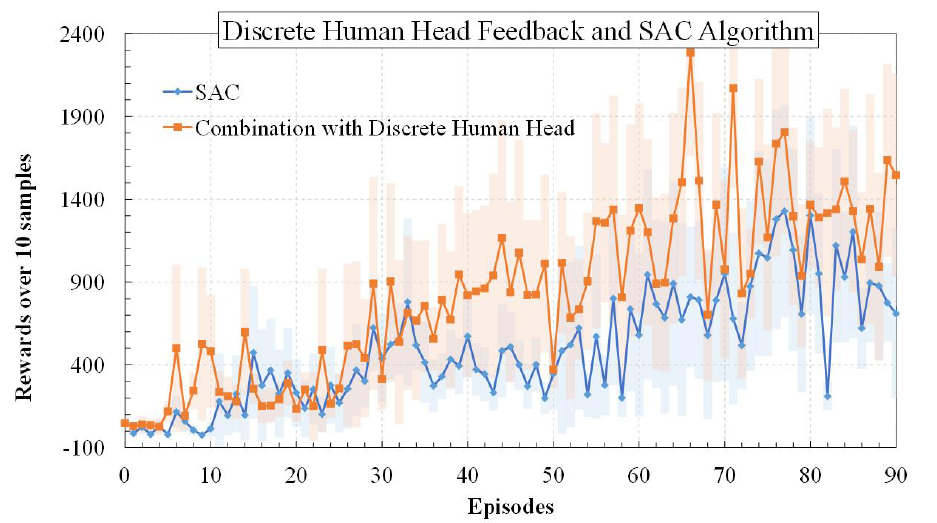
Figure 6. A comparison of the baseline SAC with the proposed method using discrete human feedback from head averaged over 10